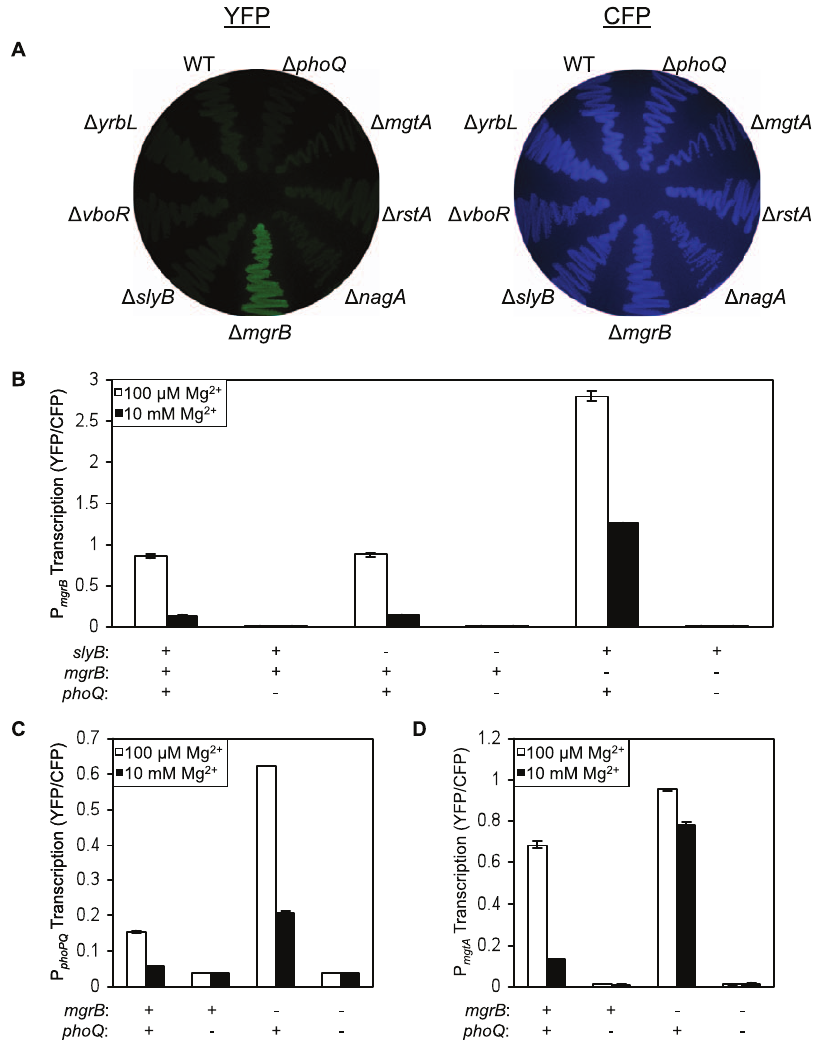
Figure 1. Deletion of mgrB leads to up-regulation of multiple genes in the PhoQ/PhoP Regulon. (A) YFP (left) and CFP (right) fluorescence images of a transcriptional reporter strain with deletions of various PhoP-regulated genes, growing on LB agar. The strain contains a chromosomal copy of the PhoP-regulated mgrB promoter (P mgrB ) driving yfp expression and a constitutive promoter driving cfp expression as an internal reference. The specific strains are, clockwise starting with WT, TIM92, TIM100, AML4, AML6, AML8, AML16, AML10, AML12, and AML14. (B) Fluorescence of several strains (as in A) grown in liquid. (C) Fluorescence of phoPQ transcriptional reporters grown in liquid. The strains are, from left to right, TIM148, TIM229, AML22, and AML23. (D) Fluorescence of mgtA transcriptional reporters grown in liquid. The strains are, from left to right TIM91, TIM99, AML24, AML25. For liquid cultures, cells were grown in minimal glucose medium with 100 m M (white) or 10 mM (black) MgSO 4 and cellular fluorescence was measured by microscopy and image analysis as described in Materials and Methods. The error bars represent the range of means for two independent cultures.